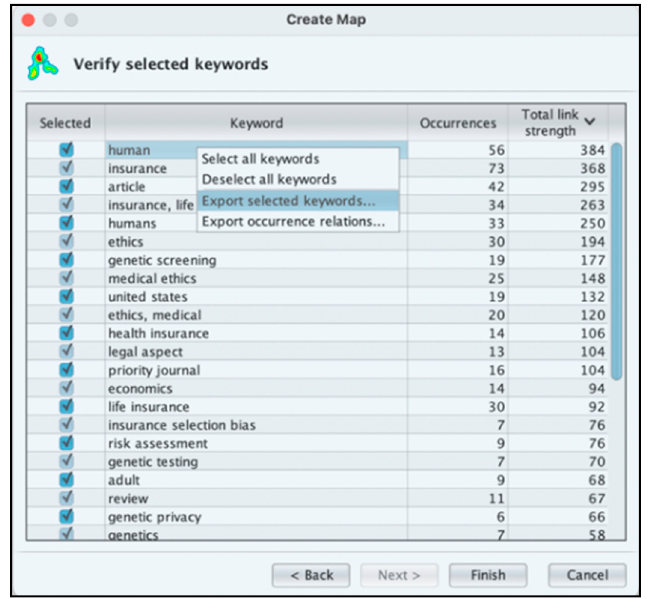
Figure A5. Exported all selected keywords .